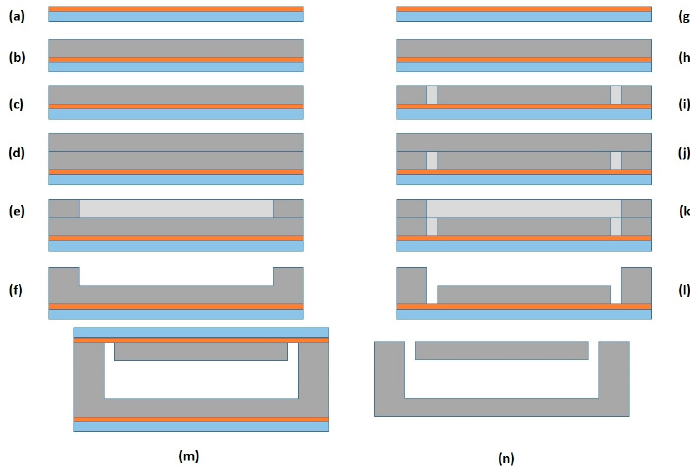
Figure 4. Fabrication process with: ( a ) pyrex-kapton bonding; ( b ) a 90 μ m SU8 layer; ( c ) ground